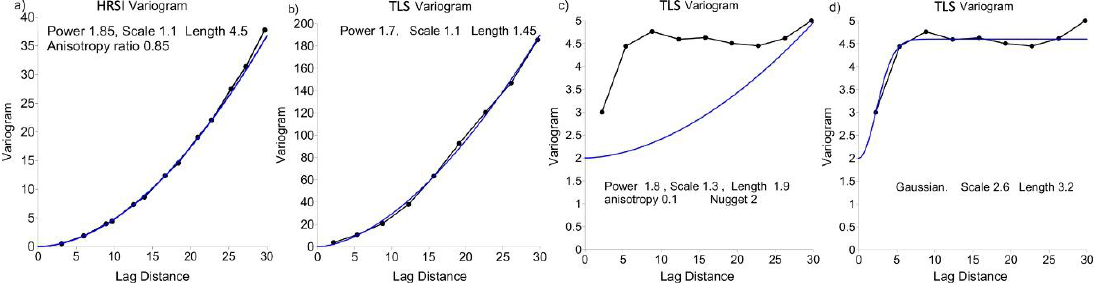
Figure 6. HRSI variogram ( a ) with anisotropy; ( b ) TLS variogram; ( c ) poor model fit of the previous TLS variogram in the 90° direction; ( d ) specific modeling of the TLS variogram only in the 90° direction.